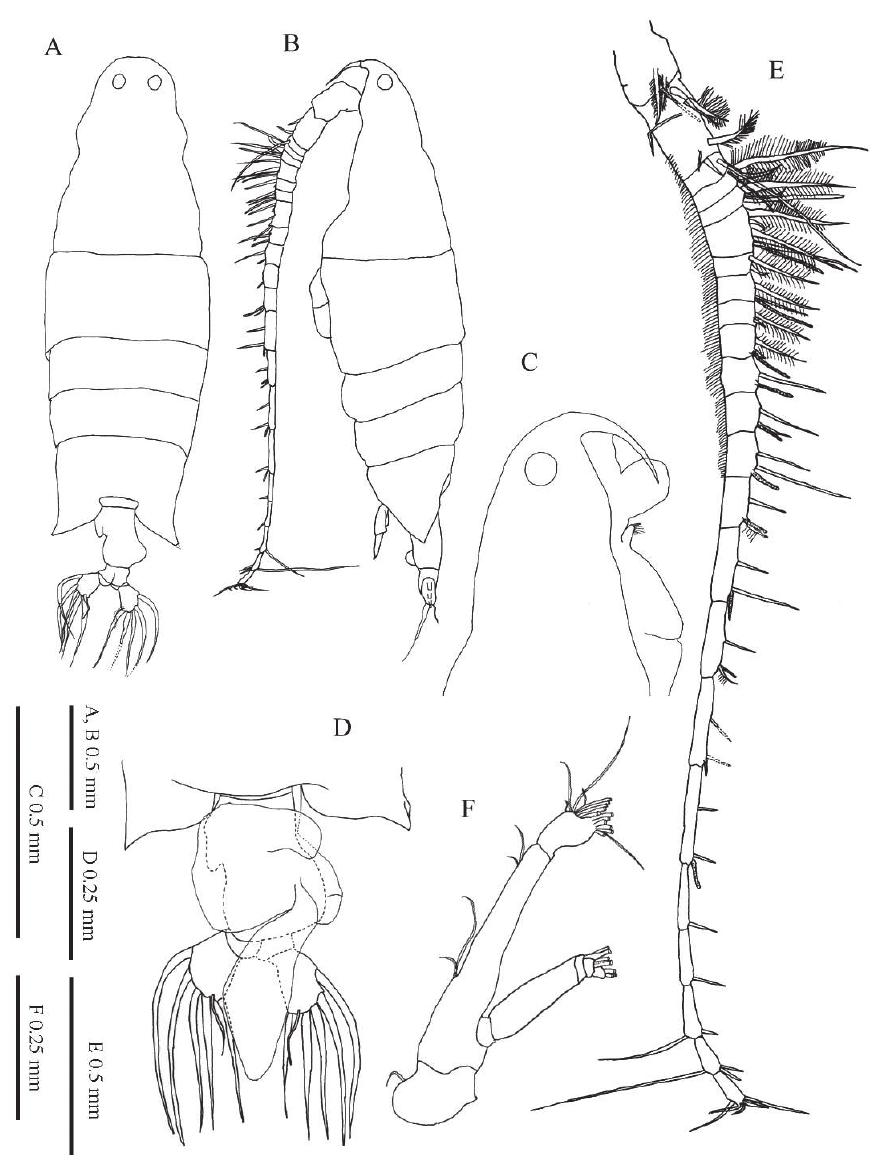
Figure 1. Labidocera churaumi sp. n., female (Paratype). A habitus, dorsal view B habitus, lateral view C anterior part of cephalosome, lateral view D urosome with outline of attached spermatophore and coupler, dorsal view E left antennule F